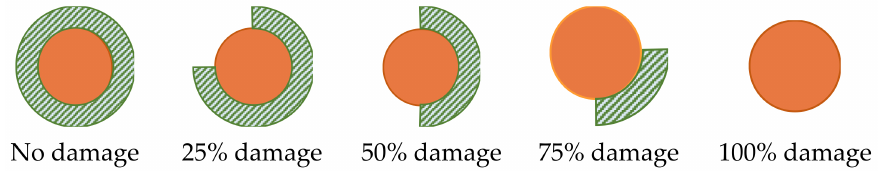
Figure 6. Illustration of cable damage degrees.